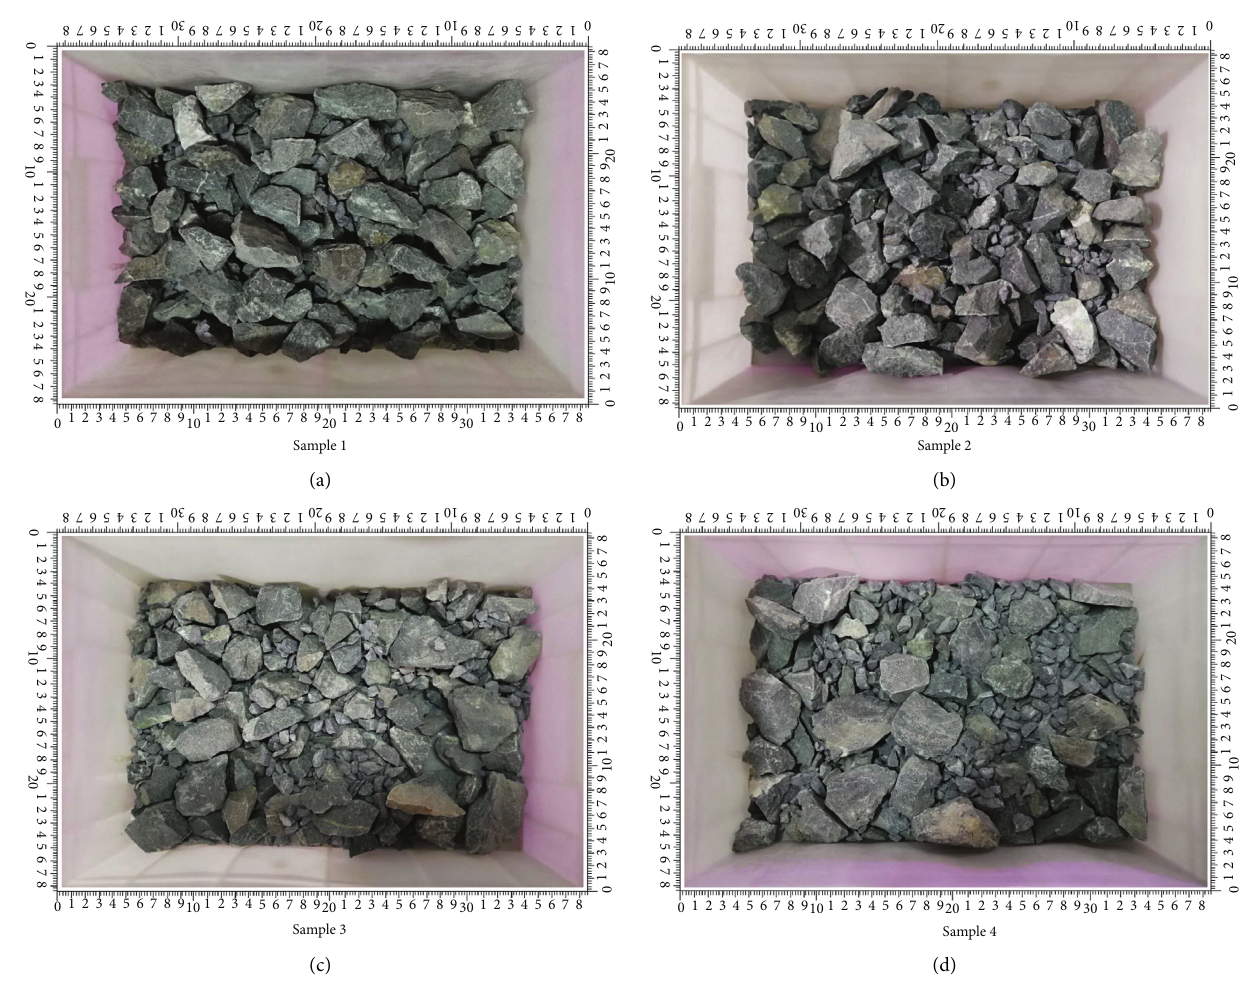
Figure 6: Photographs of limestone samples with gradations: (a) sample 1, (b) sample 2, (c) sample 3, and (d) sample